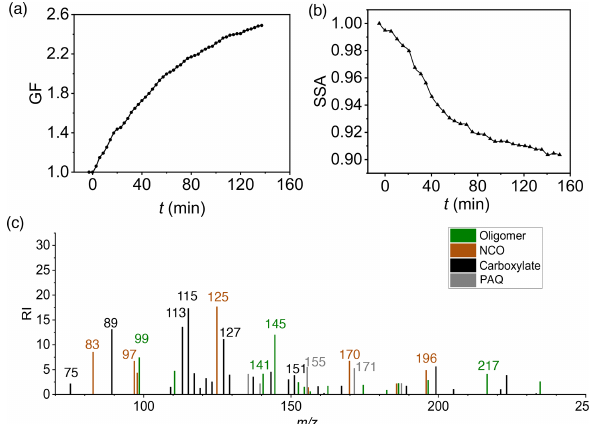
Figure 2. SOA and BrC formation from m -xylene photooxidation. Time-dependent growth factor (GF = D p /D 0 , a ) and single scatter- ing albedo (SSA, b ) of seed particles exposed to m -xylene oxidation products. (c) Chemical speciation of aerosol-phase products by the TD-ID-CIMS. Initiation of photooxidation by ultraviolet light oc- curred at t = 0. RI denotes the relative intensity for the integrated peak area during thermal desorption. All experiments are carried out for (NH 4 ) 2 SO 4 seed particles with 19ppbNH 3 at 298K and RH =